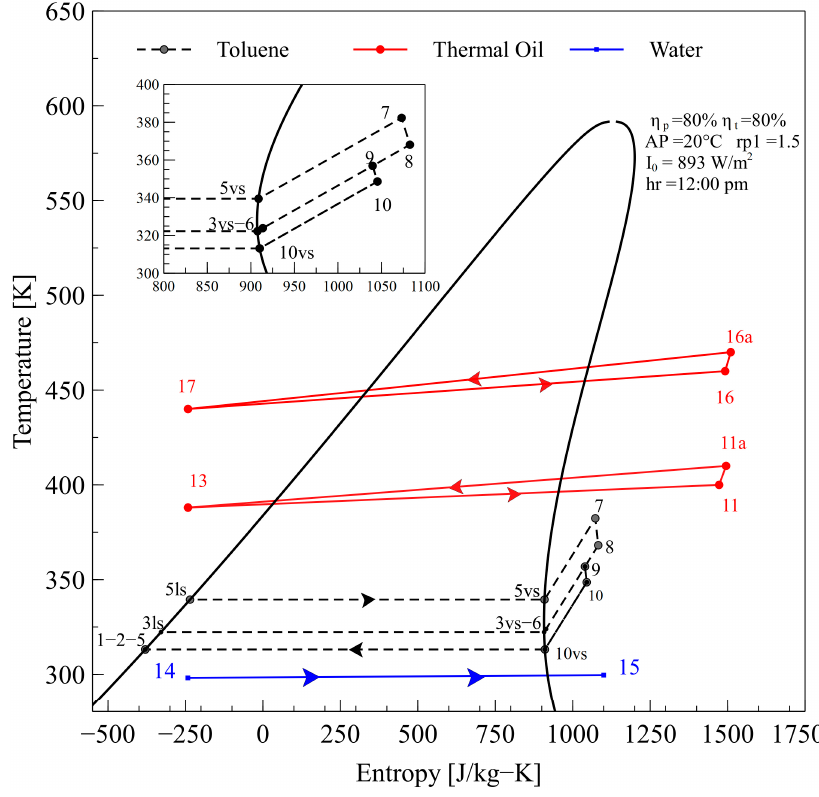
Figure 4. T–S diagram of DORC configuration.